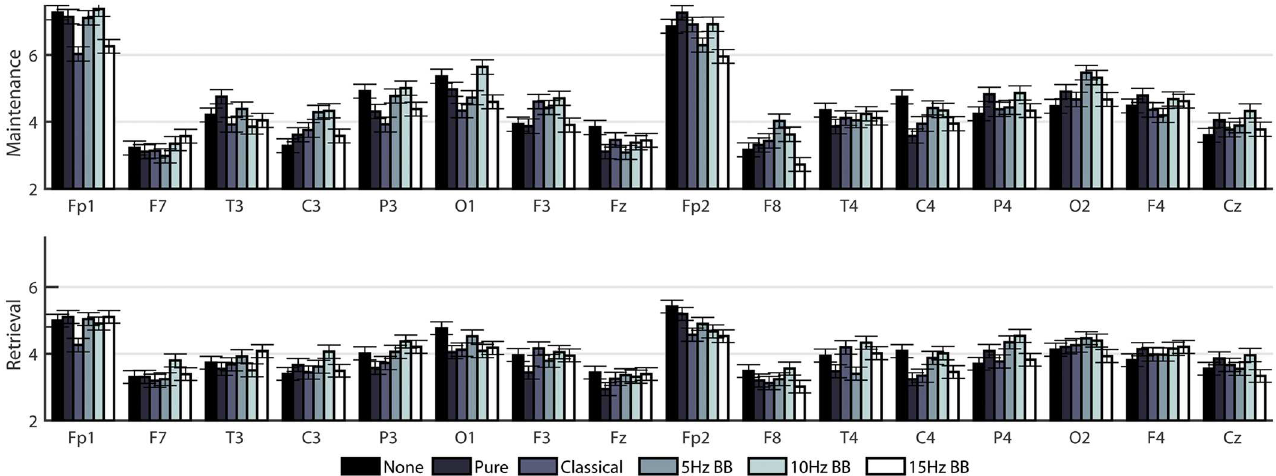
Fig 8. Mean betweenness centrality of EEG nodes in cortical networks for all six acoustic stimulation conditions. Bars indicatestandard error.